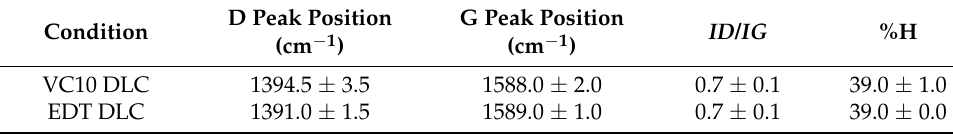
Table 6. Raman analysis